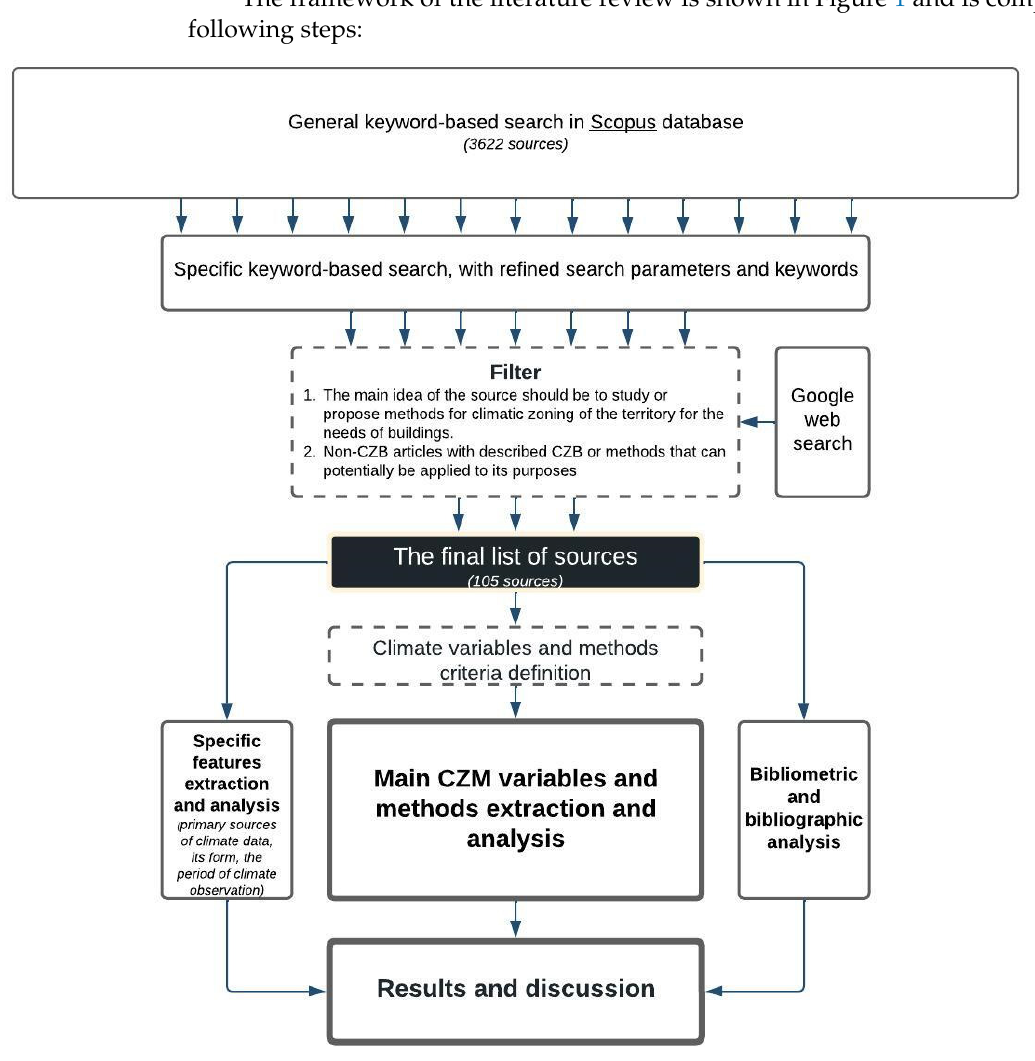
Figure 1. The review methodology flowchart.